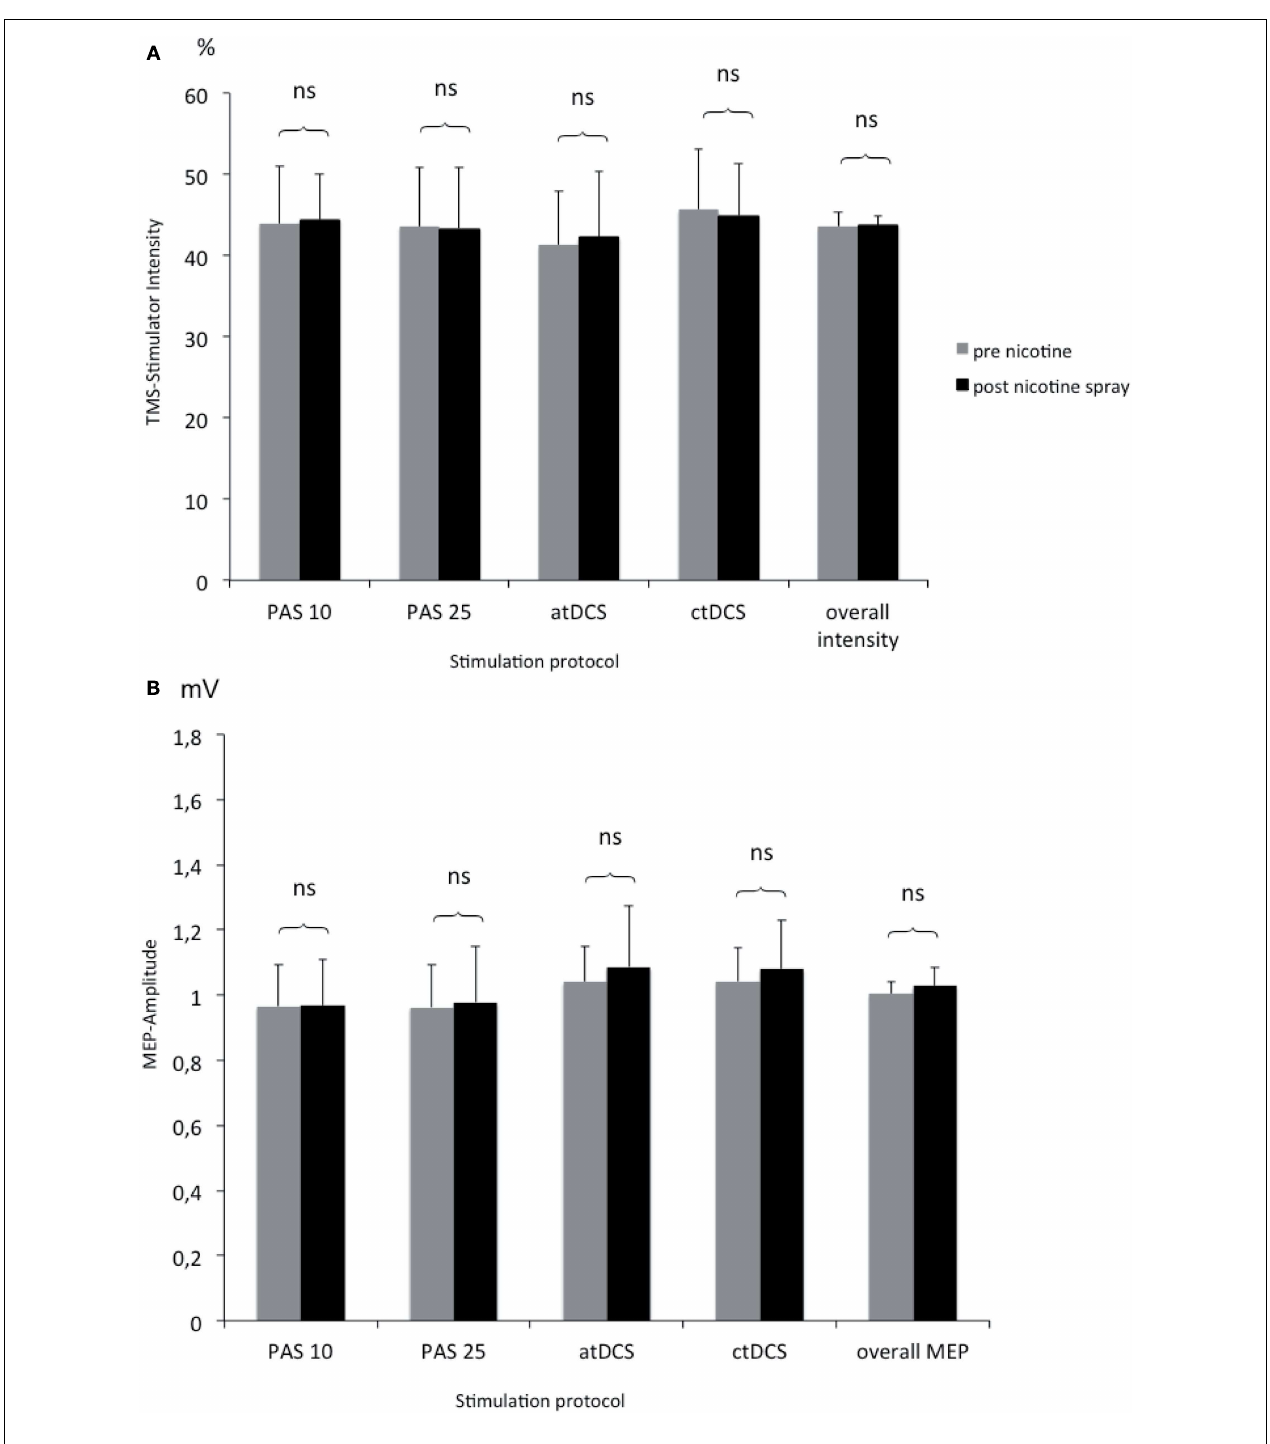
and respective motor evoked potentials [MEP amplitudes in mV; (B) ] before and after nicotine spray administration for the different interventions (atDCS, ctDCS, PAS-25, PAS-10). ns, Non significant; mV, millivolt.